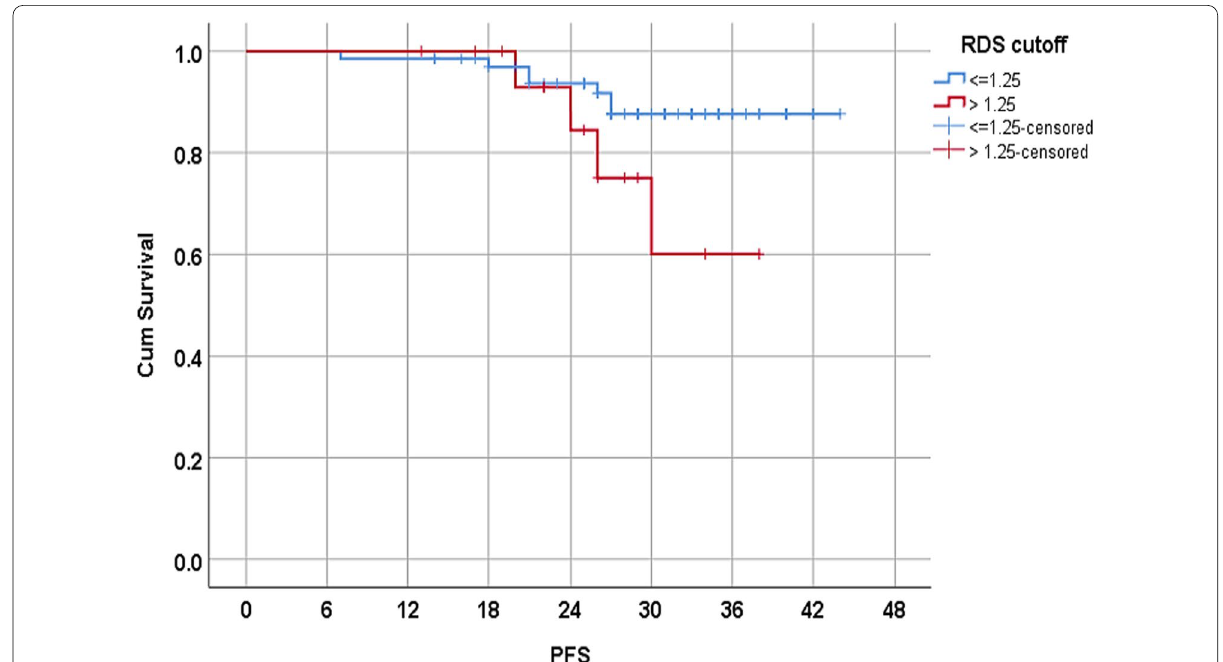
Fig. 4 Progression‑free survival curves for rDS above and below the cutoff